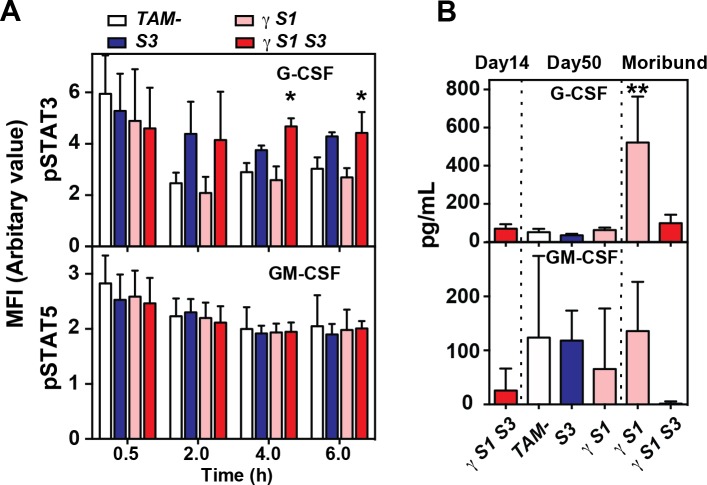
Cytokine signalling and serum concentrations in mice lacking SOCS proteins.(A) PhosFlow measurement of phosphorylated STAT3 (upper panel) and STAT5 (lower panel) in granulocytes prepared from mice 14d after tamoxifen or vehicle treatment. Cells were stimulated with G-CSF or GM-CSF for the times indicated. MFI, mean fluorescence intensity. Mean ± SD is shown with * p<0.05 for comparison of γS1S3 with TAM- and γS1 but not S3, one-way ANOVA with Tukey’s multiple comparisons test, n = 3 samples per time point. (B) G-CSF and GM-CSF in the serum of mice at the indicated times after tamoxifen or vehicle treatment. Mean ± SD is shown with ** p<0.05 for comparison of γS1 (moribund) with all other genotypes and times, one-way ANOVA with Tukey’s multiple comparisons test, n = 6–8 mice per group.